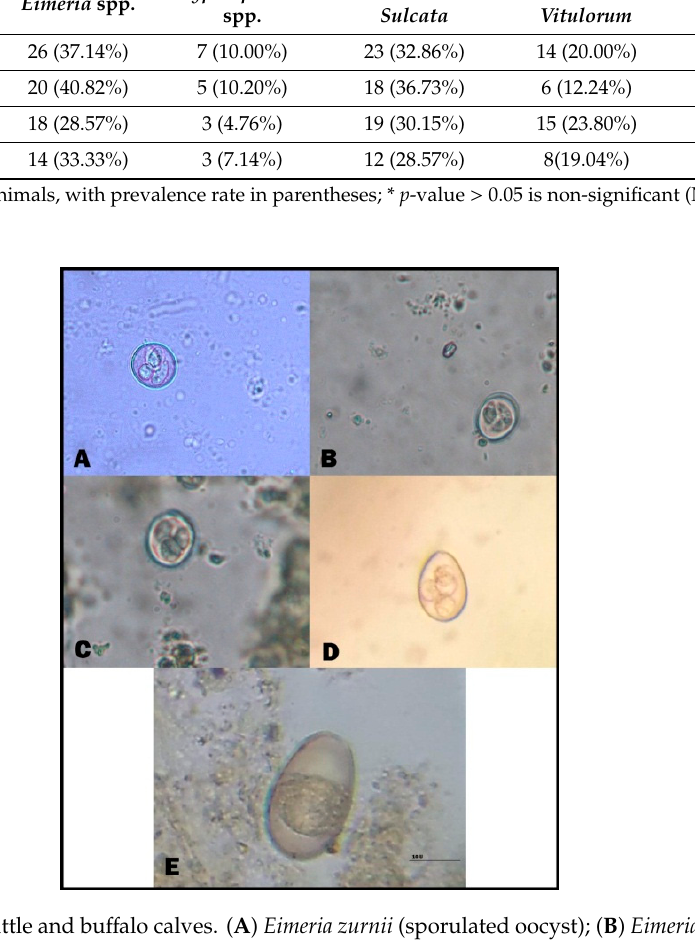
Table 3. Prevalence rate of mono-infections in diarrheic calves. Age Groups